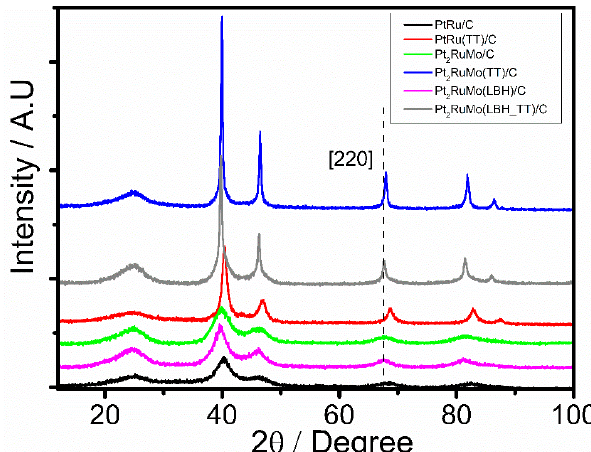
Figure 1. XRD patterns of Pt 2 RuMo catalysts and of the commercial PtRu catalyst annealed at 600 °C.